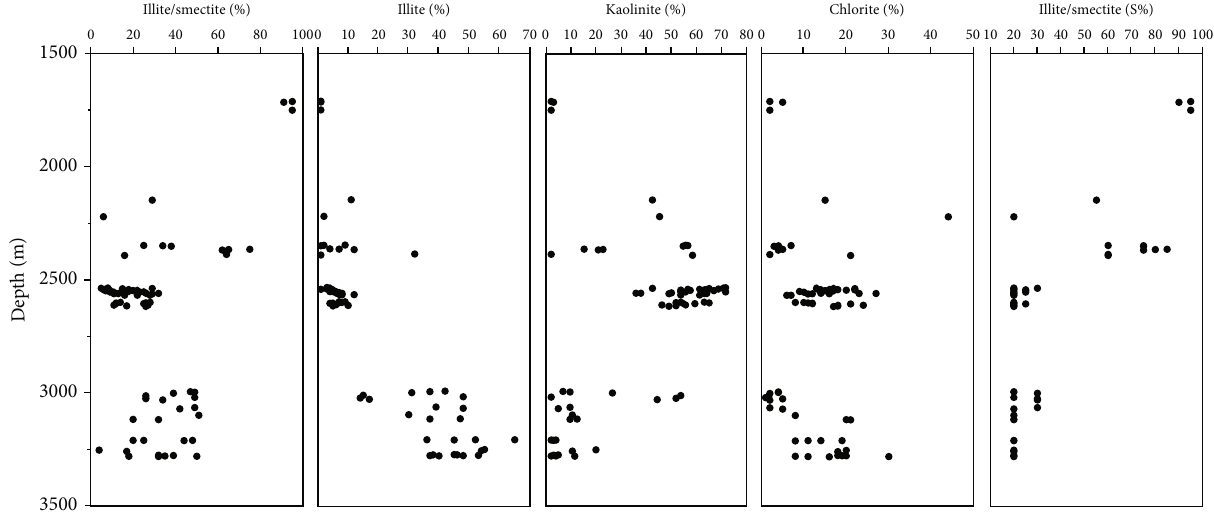
Figure 7: Vertical distribution characteristics of clay minerals in the Boxing